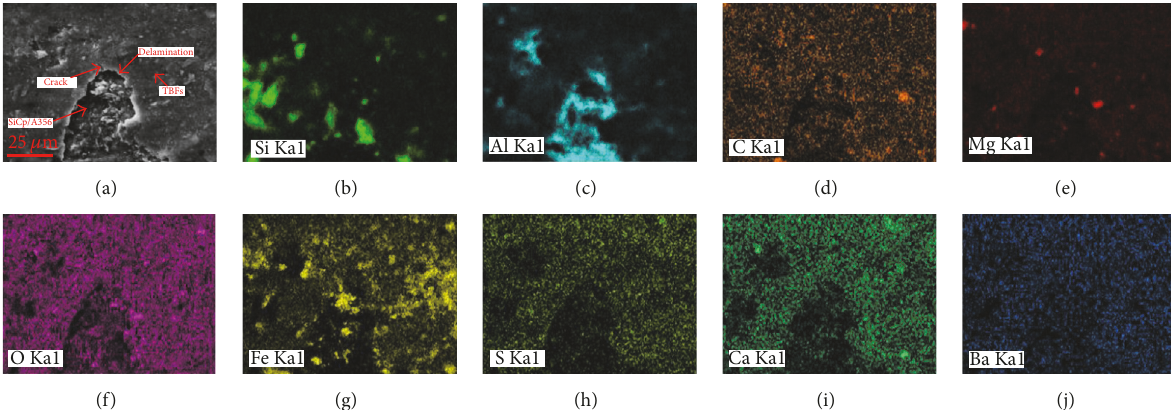
Figure 9: The surface topography and element distribution of position P1: (a) surface topography, (b) Si, (c) Al, (d) C, (e) Mg, (f) O, (g) Fe, (h) S, (i) Ca, and (j) Ba.